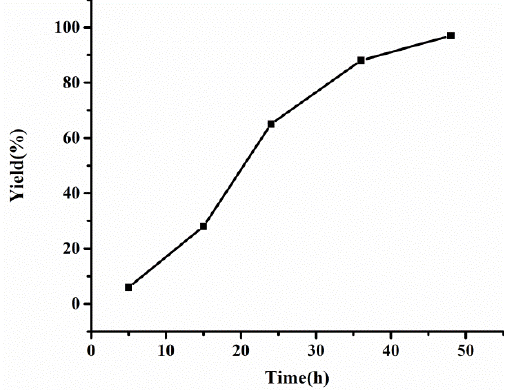
Figure 1. Plot of reaction time vs. yield of the polyisoprene obtained in Table 1, entries 3 − 7. Table 1. Effects of temperature and time of VCl 3 / methylaluminoxane (MAO) catalyst a.